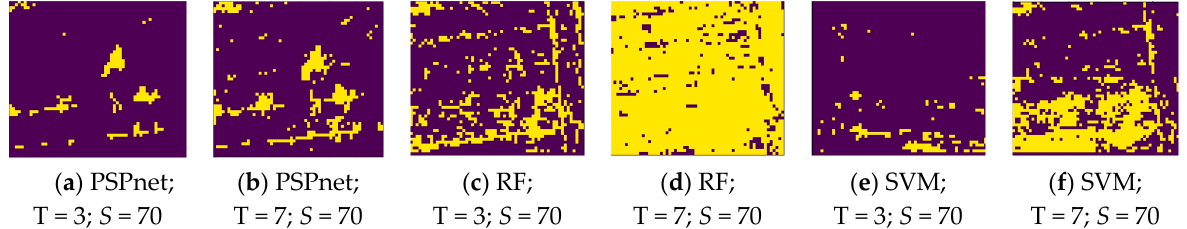
Figure 8. Binary images obtained by the different thresholds under three classification methods.